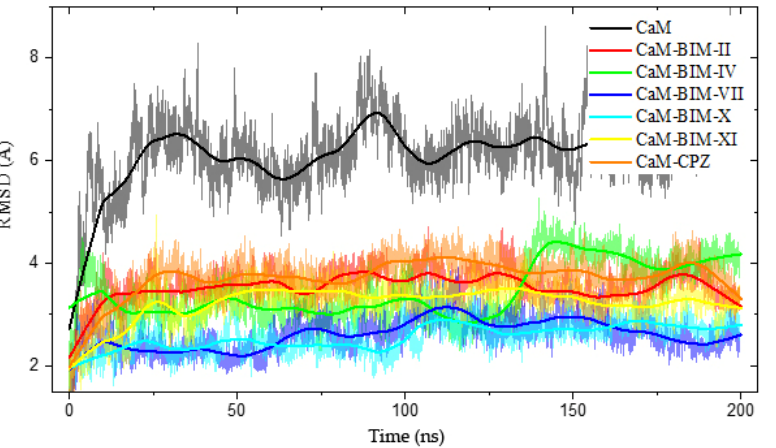
Figure 8. The RMSD & Time plot for 200 ns MD simulation. Shows the differences between closed CaM and CaM-BIM-II, CaM-BIM-IV, CaM-BIM-VII, CaM-BIM-X, CaM-BIM-XI, and CaM-CPZ.